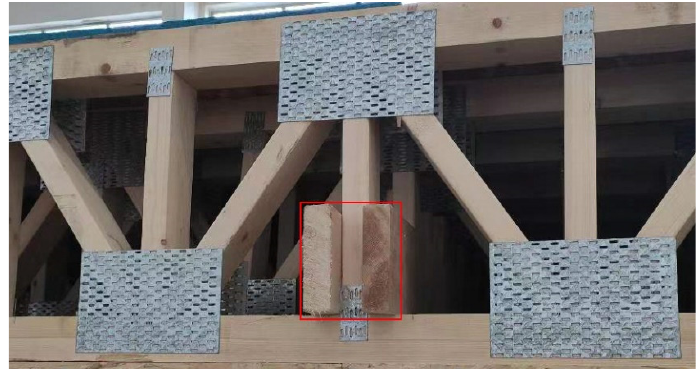
Figure 6. Double strongbacks rows at mid-span.